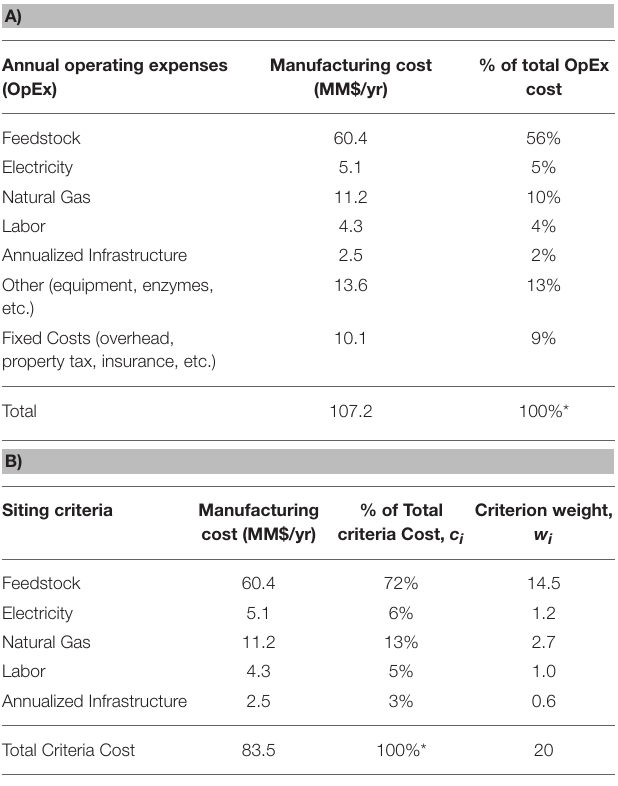
TABLE 7 | (A) Biorefinery operational expenses and (B) Conversion to decision matrix